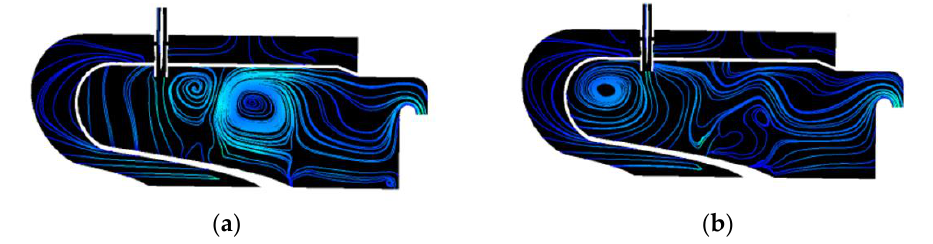
Figure 3. Streamlines with the first row of holes is closed ( a ) and open ( b ) [35].